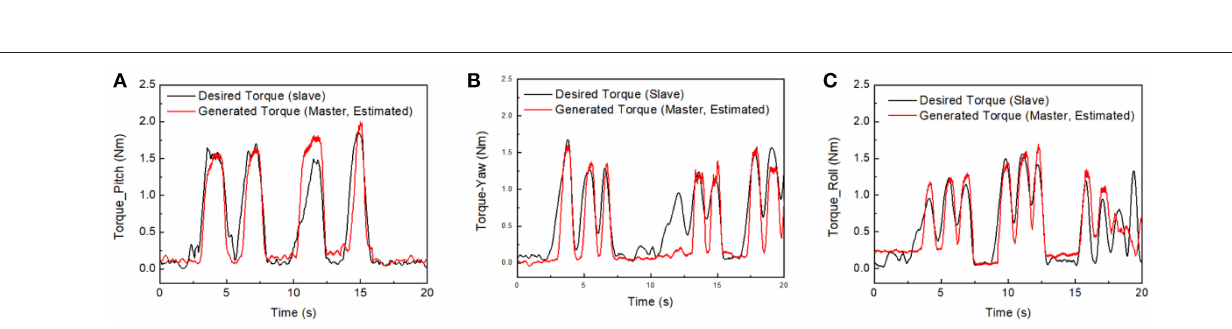
Frontiers in Materials |